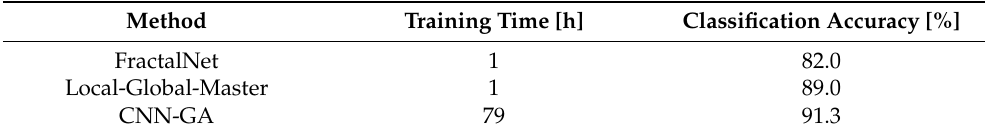
Table 1. Comparison of the validation performances of all three